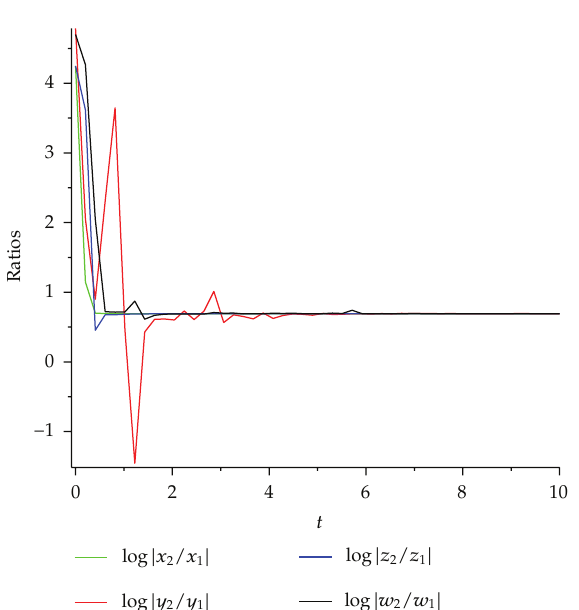
Figure 12: It shows that the evaluation of the ratios log | x 2 /x 1 | , log | y 2 /y 1 | , log | z 2 /z 1 | , and log | w 2 /w 1 | whose limits are equal to log2 (cid:8) 0 .